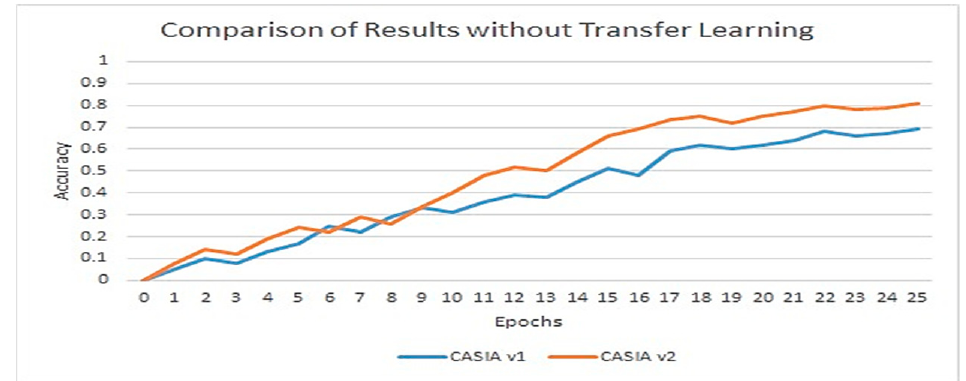
Figure 11. Testing process visualization without transfer learning.